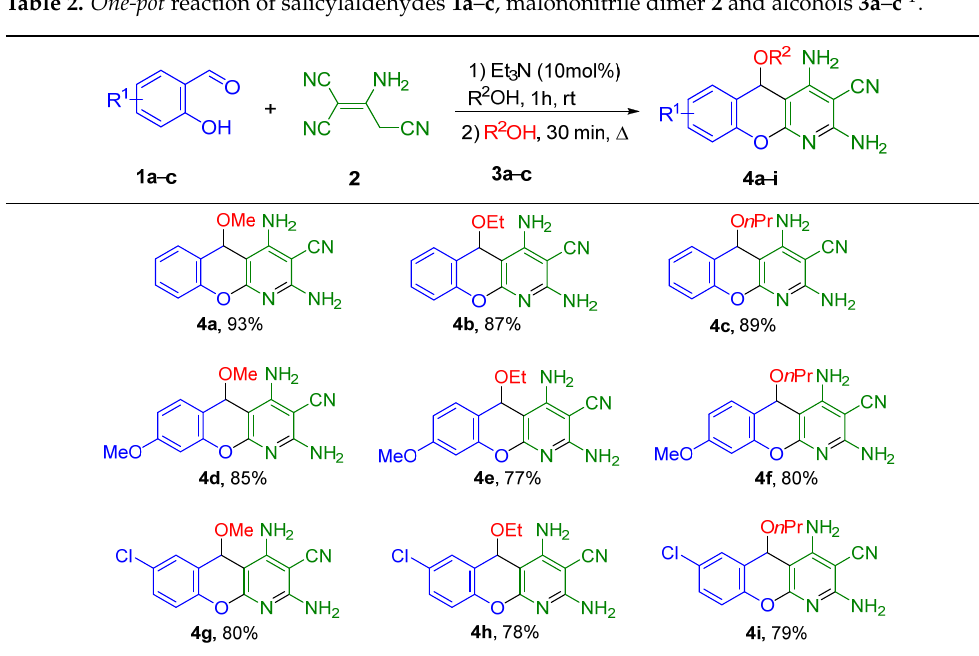
Figure 3. The structure of chromeno[2,3- b ]pyridine 4d . Key 1 H- 13 C-HMBC NMR correlations are shown by arrows.